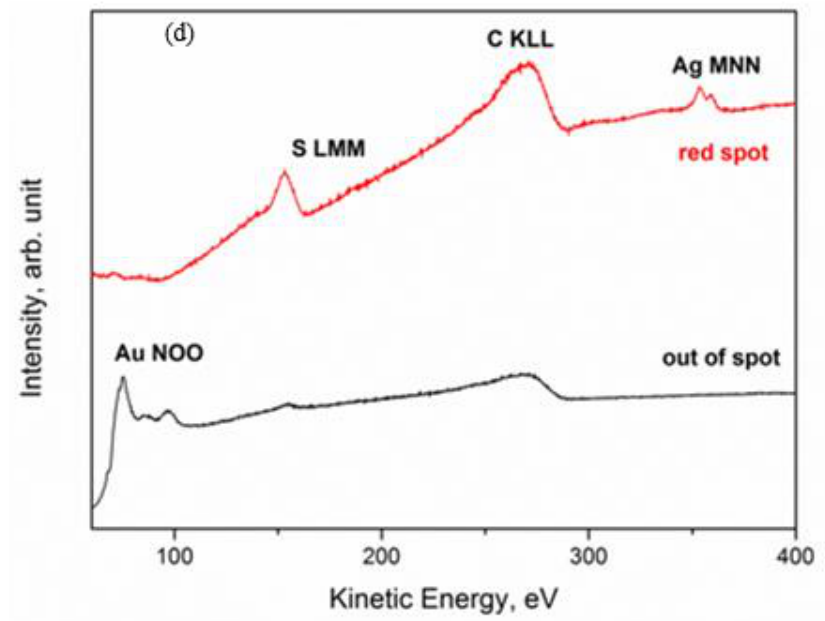
Figure 4. Auger electron spectroscopy (AES) investigation of the defect on gold coin: SEM image—size 1.8 × 1.8 mm 2 ( a ); Au NOO image ( b ); Ag MNN image ( c ) and AES spectra ( d ) acquired in the red spot (point A) and out of the spot (point B) [17].